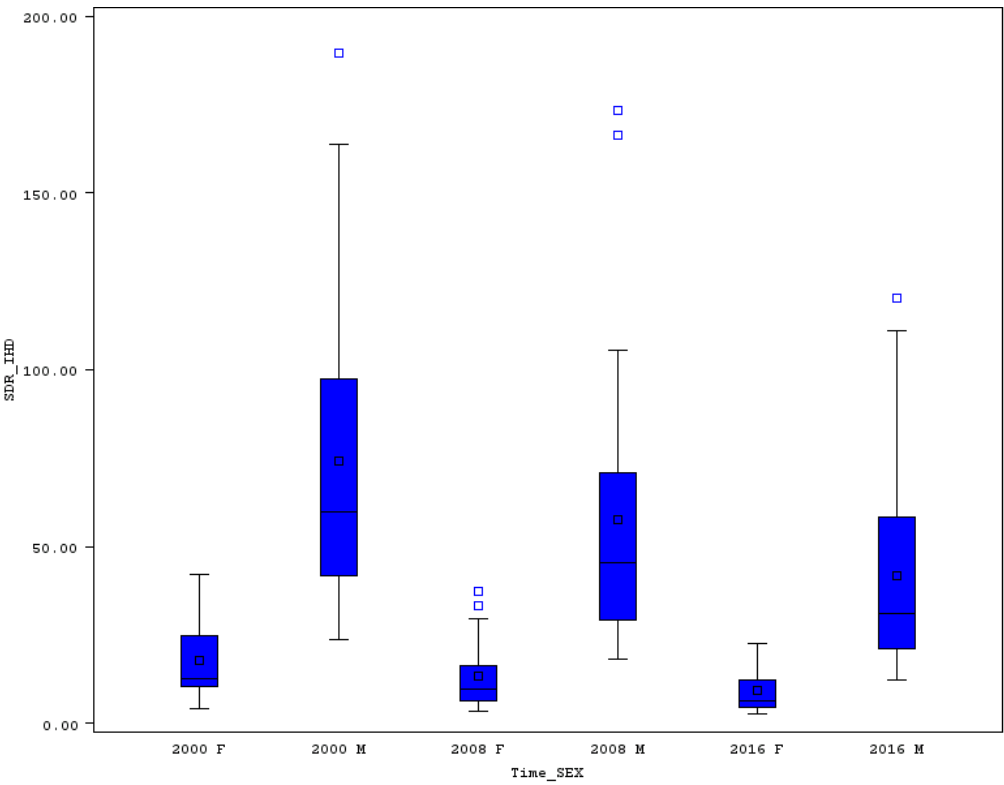
Figure 4. Boxplot of premature SDR for ischemic heart diseases in EU countries for males and females in selected years. Source: Own calculations based on Eurostat database [20].